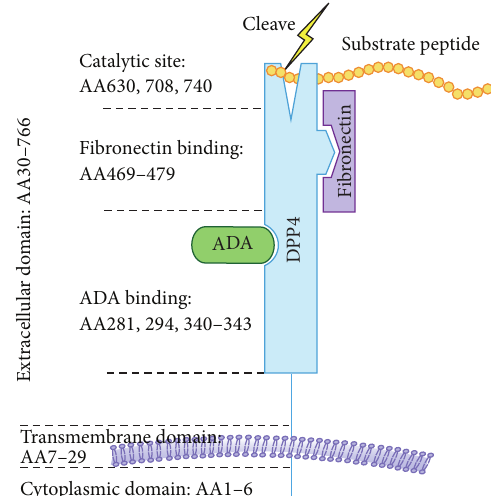
Figure 1: DPP4 molecular structure: DPP4 consists of a 6-amino- acid cytoplasmic tail, a 22-amino-acid transmembrane domain, and a large extracellular domain. The extracellular domain is responsible for the dipeptidyl-peptidase activity and binding to its ligands such as ADA and fibronectin. AA, amino acid; ADA, adenosine deaminase.